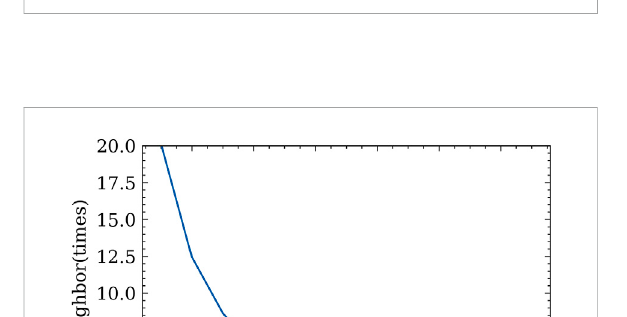
FIGURE 5 The contour of ablation area diameter changed with FWHM beam size and pulse